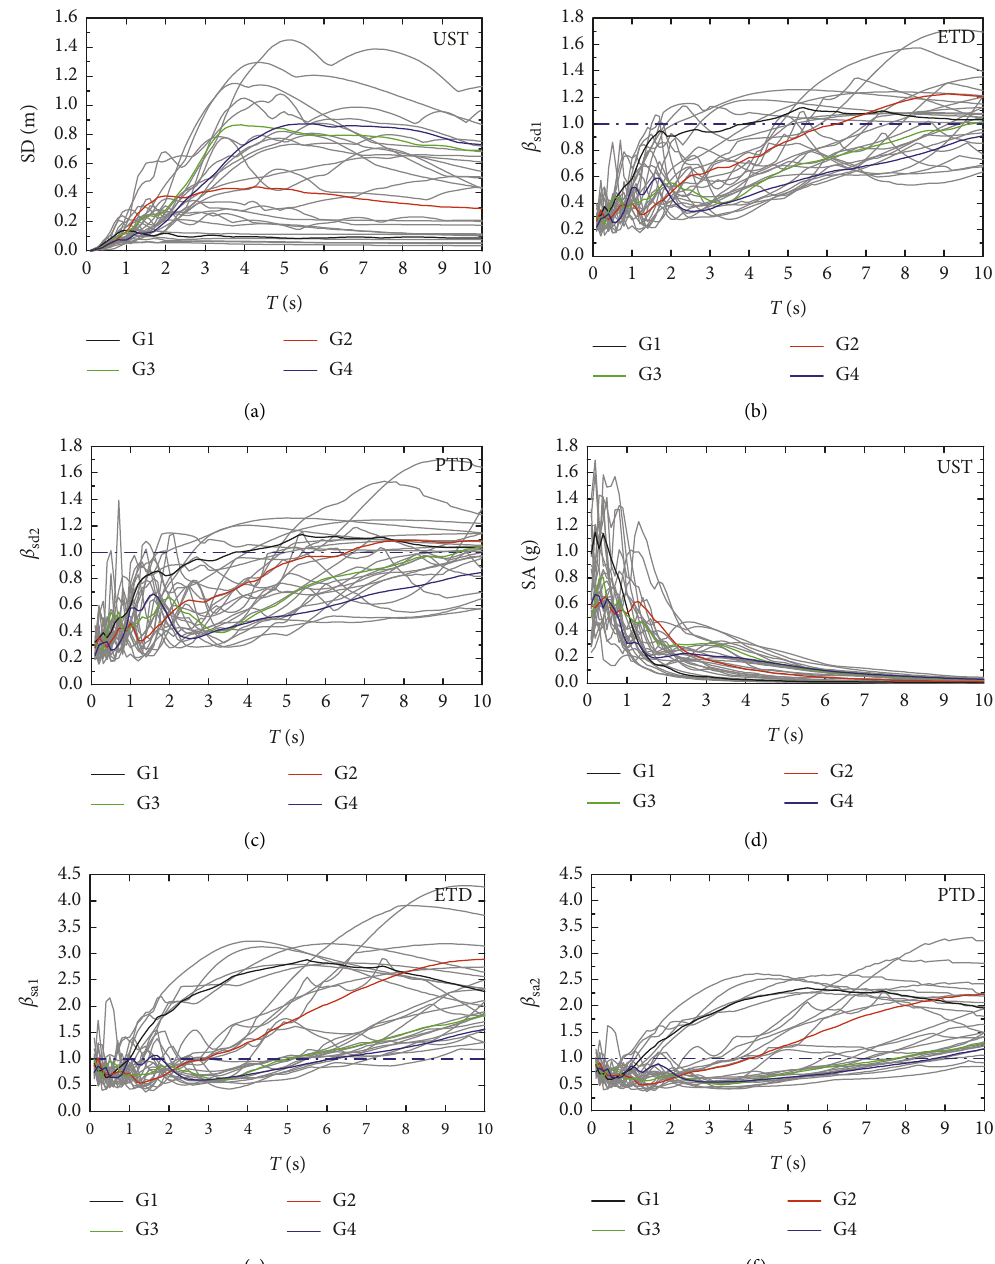
Figure 6: Displacement and acceleration spectra for different SDOF structures: (a)-(c) displacement spectra for UST, ETD, and PTD ( R � 4), respectively; (d)-(f) acceleration spectra for UST, ETD, and PTD ( R � 4),